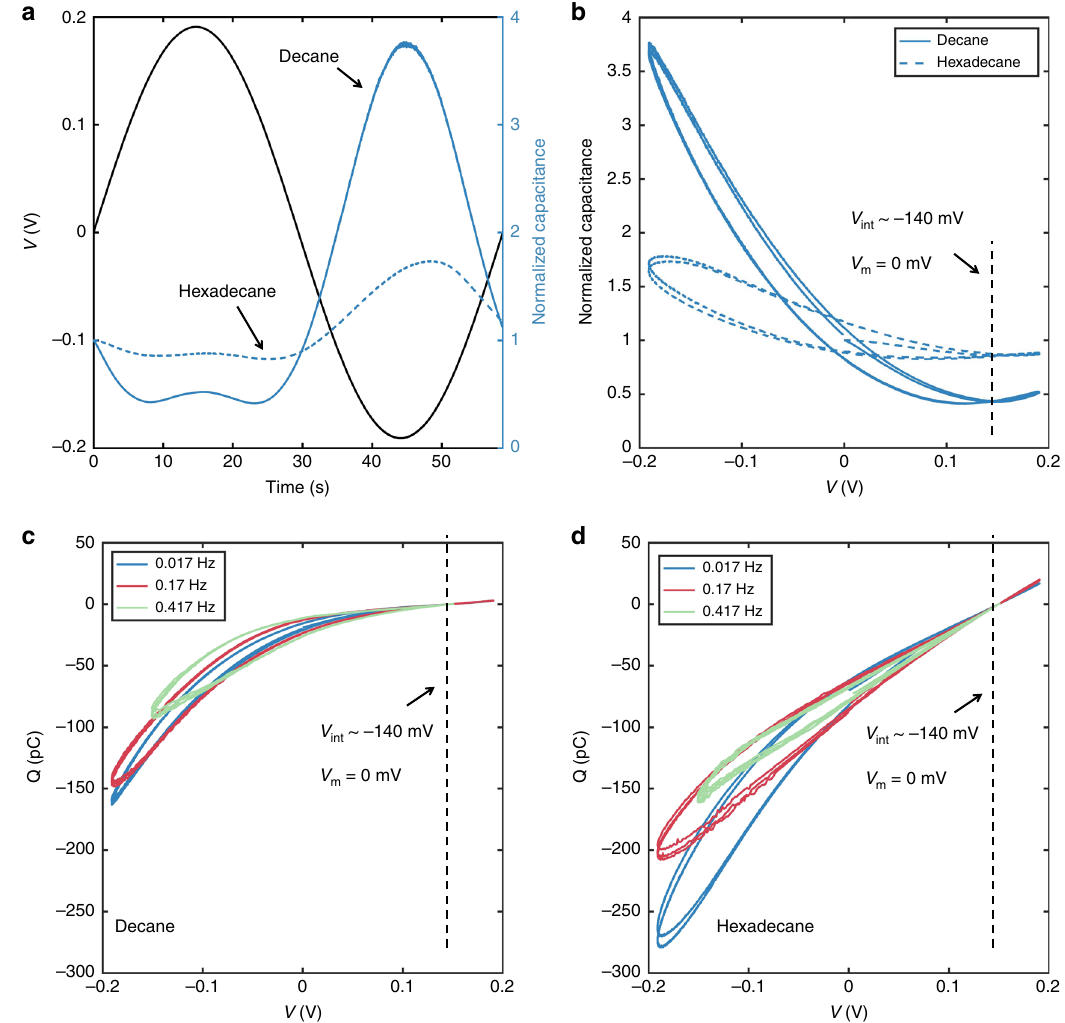
Fig. 4 Dynamical capacitance as a function of time and voltage for an asymmetric DPhPC:DOPhPC membrane. a , b show that, for both oils, minimum capacitance occurs at − 137 mV, which is equal in magnitude and opposite in sign to the intrinsic membrane potential created by the difference in dipole potentials. Unlike in symmetric membranes, where v m = v , the membrane voltage for a symmetric bilayer is given by, v m = v + v int . This explains the asymmetry in the peak capacitance values at + / − 150 mV. We also plot the Q - v relationships for asymmetric devices formed in either decane ( c ) and hexadecane ( d ). The results show asymmetric pinched-hysteresis loops, where the largest hysteresis lobes occur in the third quadrant where the magnitudes of v and v int sum. Note that the hysteresis for a membrane in hexadecane ( d ), appears larger than that of a bilayer in decane ( c ). This is due to the fact that bilayers in decane have smaller areas and larger thicknesses, and, therefore, have smaller capacitance